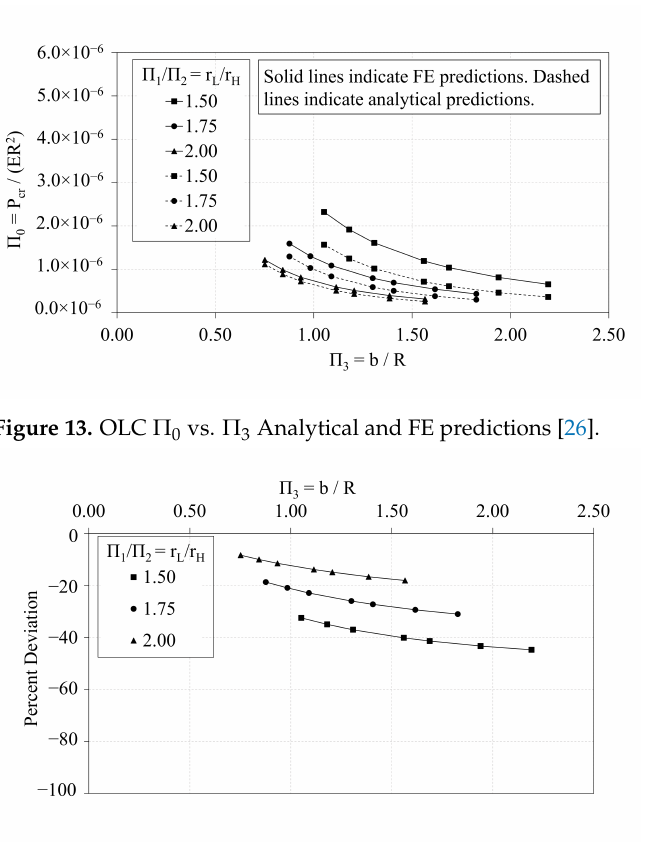
Figure 14. OLC Π 0 vs. Π 3 Percent deviation of analytical predictions from FE predictions